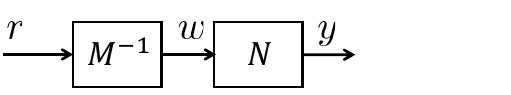
Figure 1. Operator-based control system.